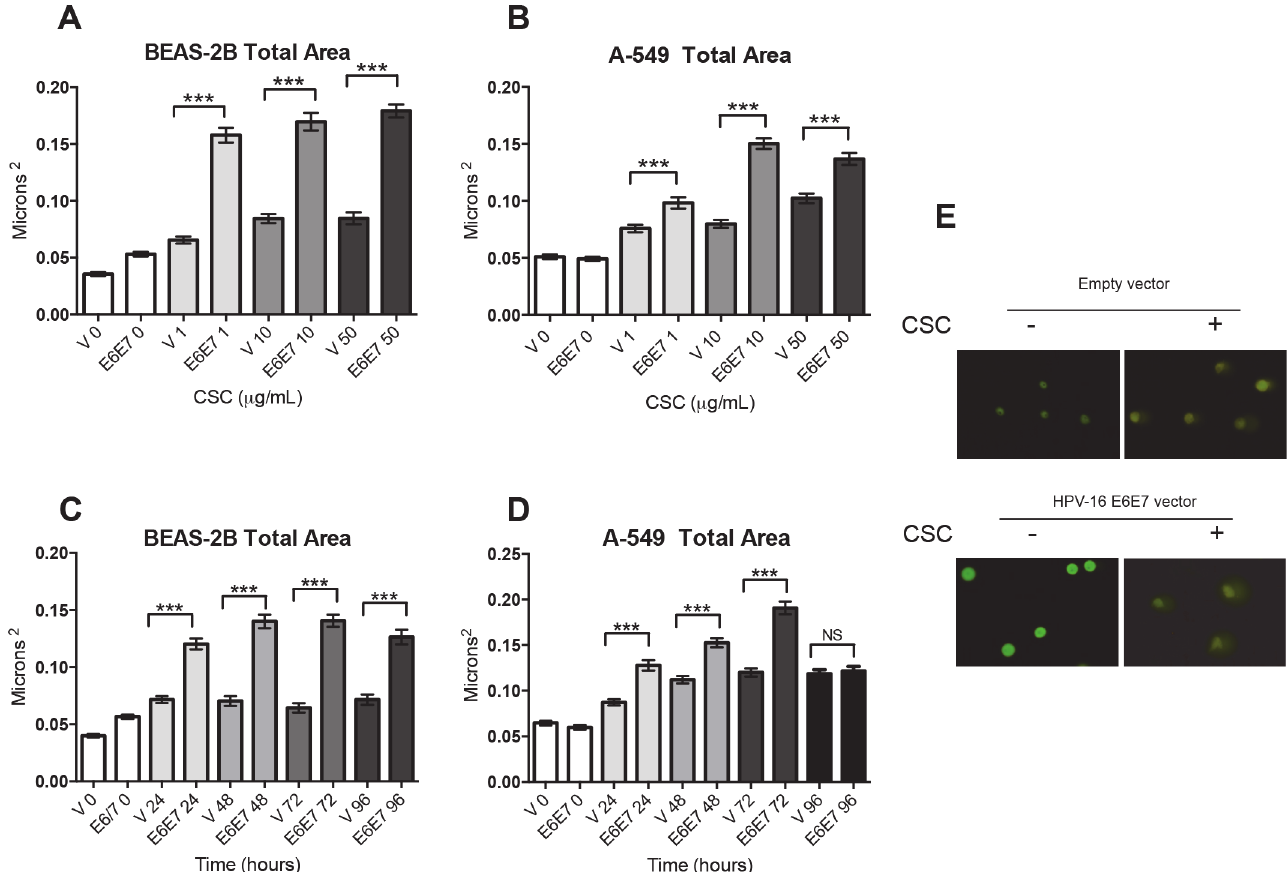
Fig 3. HPV-E6/E7 oncogenes sensitize lung cells for tobacco smoke-induced DNA damage. (A) BEAS-2B and (B) A-549 cells were exposed for 72 hours to 1 – 50 μ g/mL CSC and analyzed using comet assay. ( C ) BEAS-2B and (D) A-549 cells were exposed to 10 μ g/mL CSC for 0 – 96 hours. (E) Image showing comets in A-549 cells transfected with HPV-16 E6E7 or an empty vector and exposed to 10 μ g/mL CSC. The graphs are representative of three independent experiments ( * = p < 0.05; ** = p < 0.01; *** = p < 0.001, Total Area ± SEM).